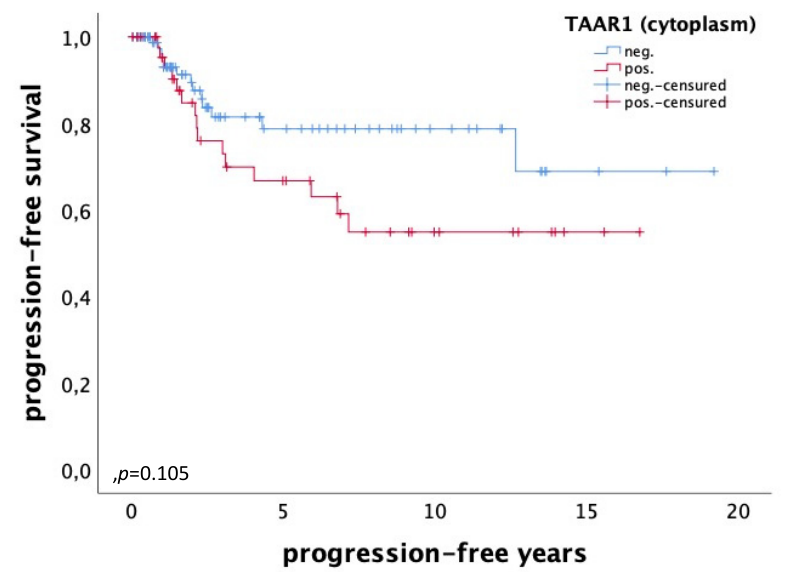
Figure 6. Progression-free survival of patients with ovarian carcinoma with a high ( n = 47) and a low ( n = 86) cytoplasmic TAAR1 expression. High cytoplasmic TAAR1 expression is tendentially associated with a worse progression-free survival in ovarian cancer patients ( p = 0.105); ,* p < 0.05 was considered statistically significant.